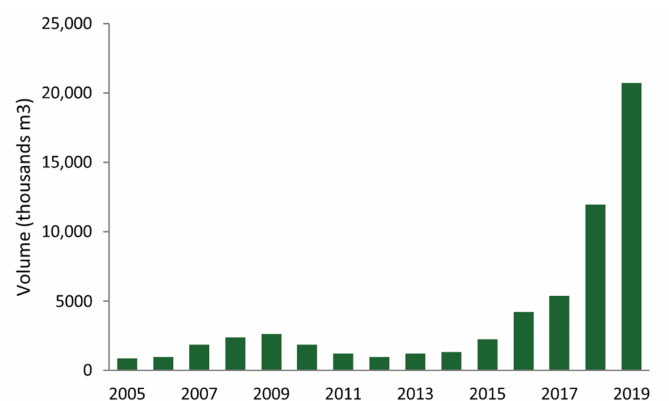
Figure 5. Recorded volume of infested spruce wood harvested in the years 2005 to 2019. Source: Ministry of Agriculture of the Czech Republic, 2020 [31].